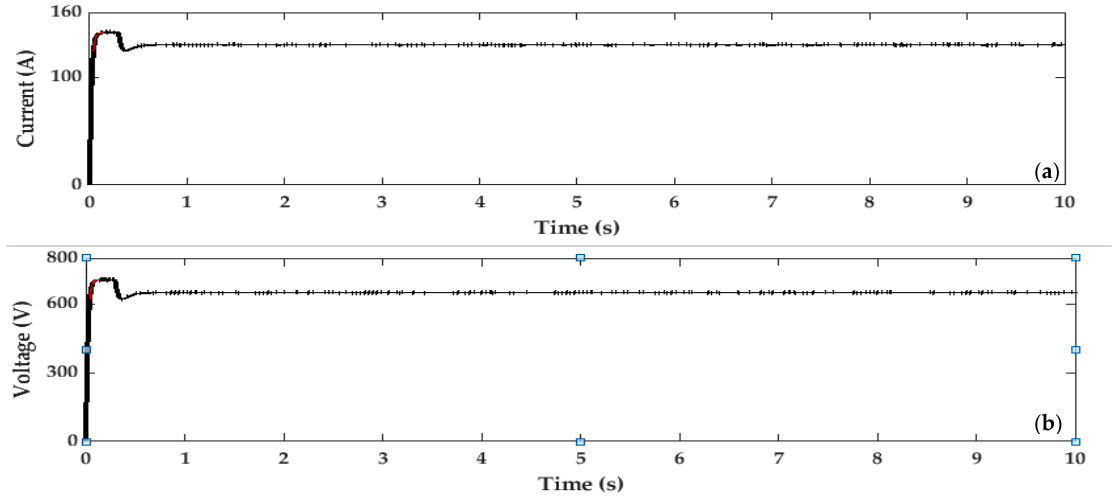
Figure 11. The current and voltage waveforms of DC fast charging: ( a ) current, ( b ) voltage.